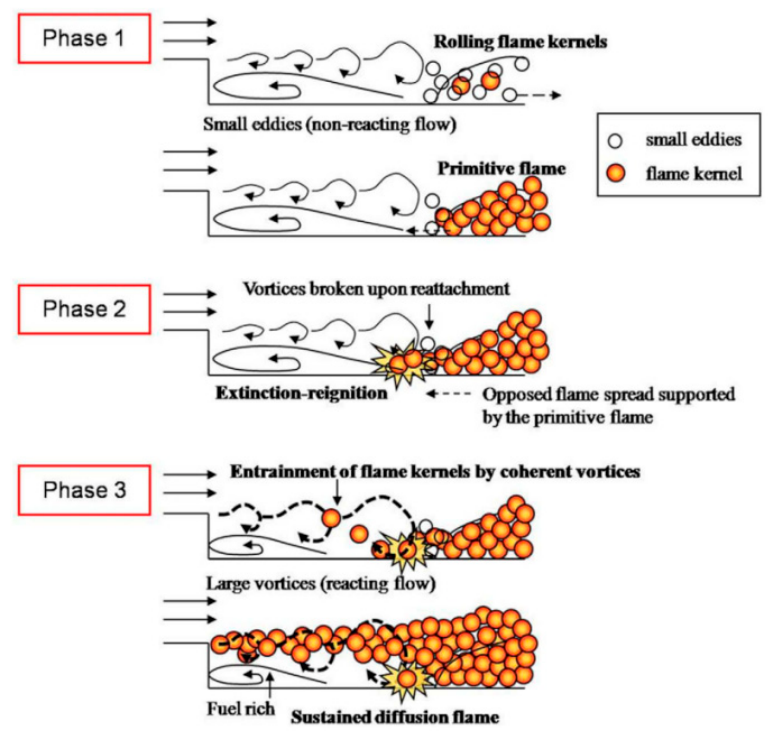
Figure 4. Three phases of the transient flame spread [59].